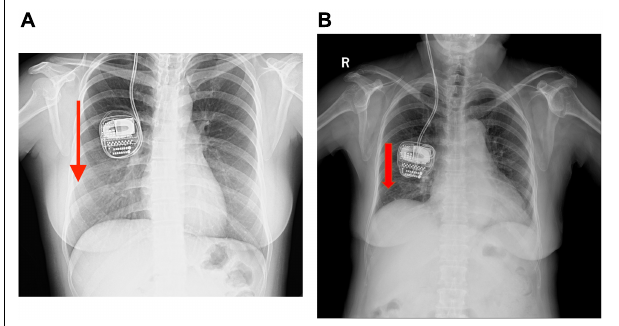
FIGURE 2 | (A,B) Plain chest X-rays showing that the rechargeable implanted pulse generators (r-IPGs) were inside out. No fracturing or twisting of the leads was observed. The red arrow means that the r-IPG was inside